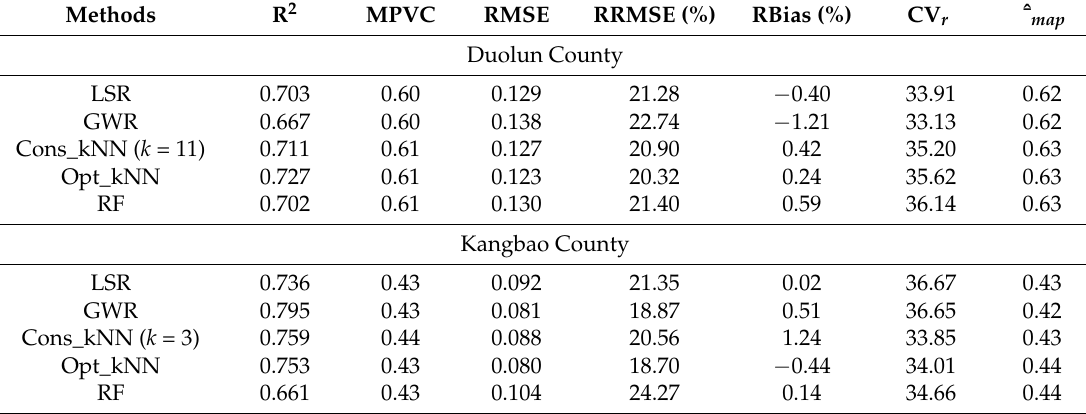
Table 3. Comparison of percentage vegetation cover (PVC) prediction accuracies among five methods including linear stepwise regression (LSR), geographically weighted regression (GWR), constant kNN with a globally optimal k (Cons_kNN), optimized kNN with local optimal k values, (Opt_kNN) and random forest (RF) for both Duolun and Kangbao County (R 2 , RMSE and RRMSE are the coefficient of determination, root mean square error and relative RMSE for plots; MPVC and RBias are the mean prediction and relative bias of PVC for the plots; ˆ µ map and CV r are the mean prediction and coefficient of variation of PVC for the maps; and the confidence interval was 0.58 to 0.63 for Duolun and 0.40 to 0.46 for